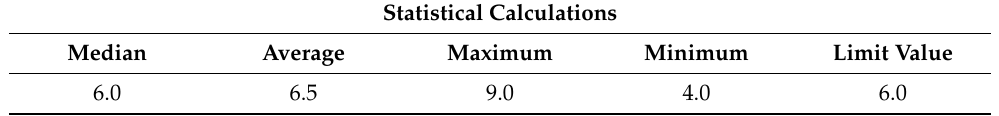
Table 12. Statistical Calculations.